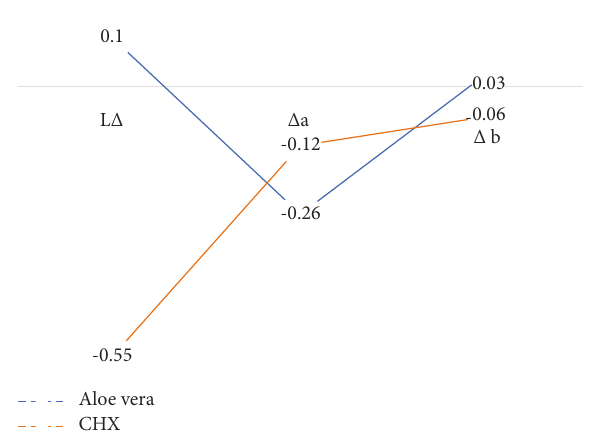
Figure 2: The comparison of Δ L , Δ a , and Δ b mean color